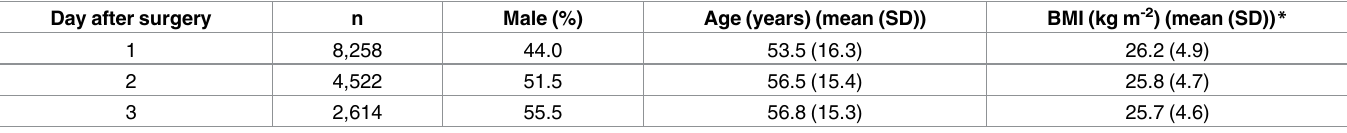
Table 2. Numbers and characteristics of